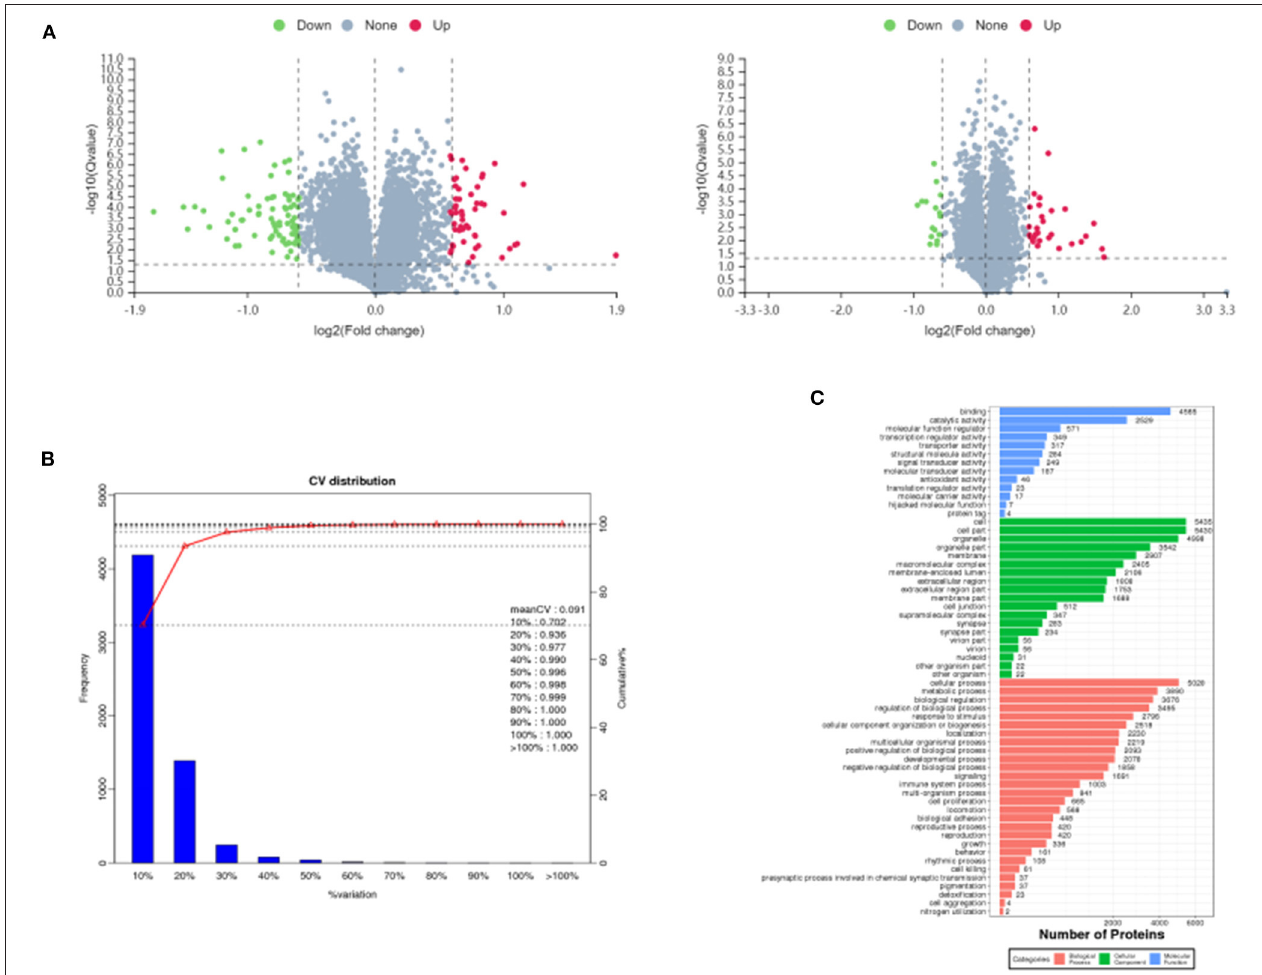
FIGURE 4 | Volcano plots of differentially expressed proteins in MC/BC (left) and HD/MC (right) (A) , distribution of CV values of replicate experiments (B) and GO annotation histogram (C) .